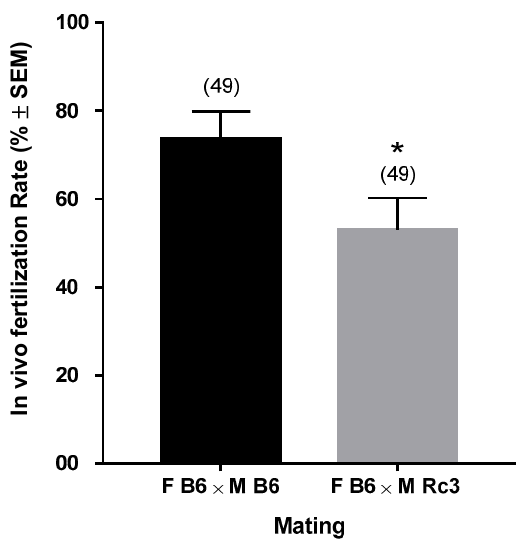
Figure 3. Evaluation of in vivo fertilization: B6 females were mated with B6 or Rc3 males to evaluate their respective capacity to fertilize oocytes in vivo. The mating was performed on the night and the next day, oocytes from oviducts of females with a positive vaginal plug were collected. The fertilization was assessed using 4 ′ ,6-diamidino-2-phenylindole (DAPI) fluorescent staining. The results are presented as the mean of the fertilization rate (%) ± SEM using t-test. * p = 0.036. F: female, M: male. ( ) number of oocytes.